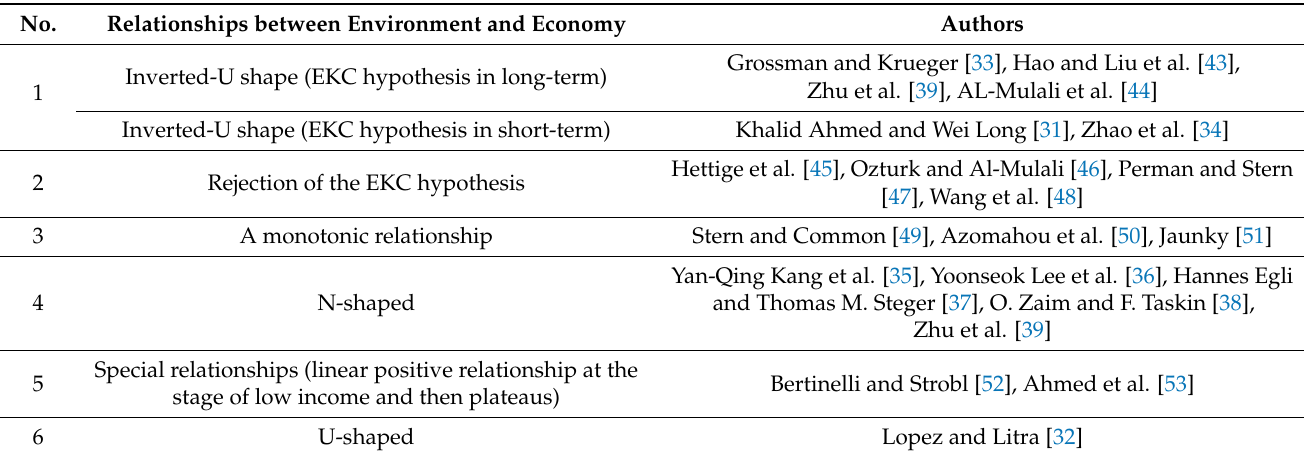
Table 1. The main findings of the study on the relationship between economy and environment and their